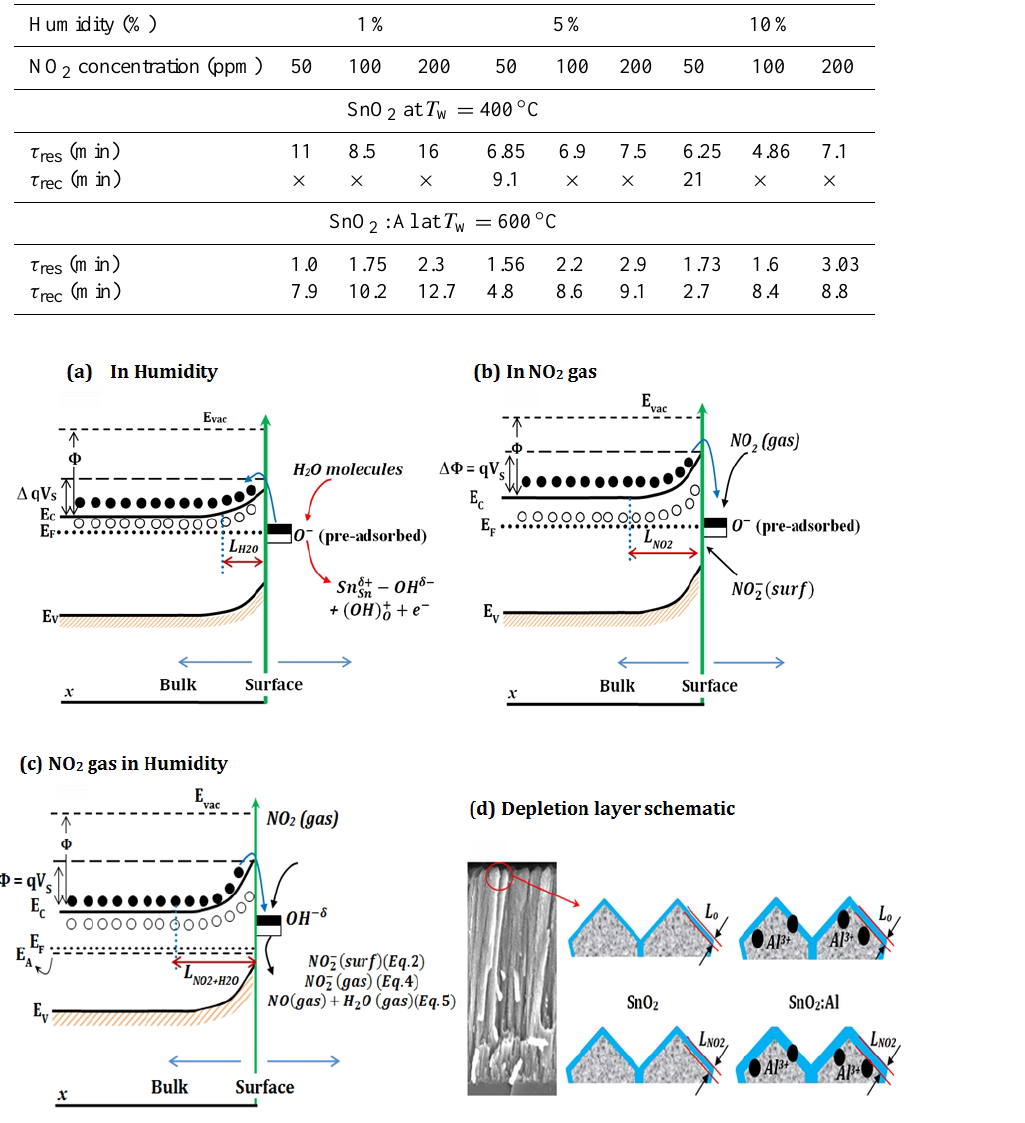
Figure 7. The illustration of the band bending due to the adsorption of oxygen species for an n-type semiconductor such as a SnO 2 layer. The schematic of chemisorption (a) NO 2 and (b) water molecules at the surface of an n-type SnO 2 . (c) The surface reaction of SnO 2 :Al columnar structures with NO 2 under a humid environment is presented, where NO 2 reacts with pre-adsorbed OH δ − groups for improved sensitivity. (d) The schematic of the depletion layer due to adsorption of oxygen from the environment and reaction with oxidizing gases such as NO 2 ; L o and L NO represent the depletion region on columnar morphology in argon and NO 2 environments, respectively; here L o < L NO 2 and L o (SnO 2 ) (cid:28) L o (SnO 2 :Al). Electrons and holes are represented by ( • ) and ( (cid:13) ),